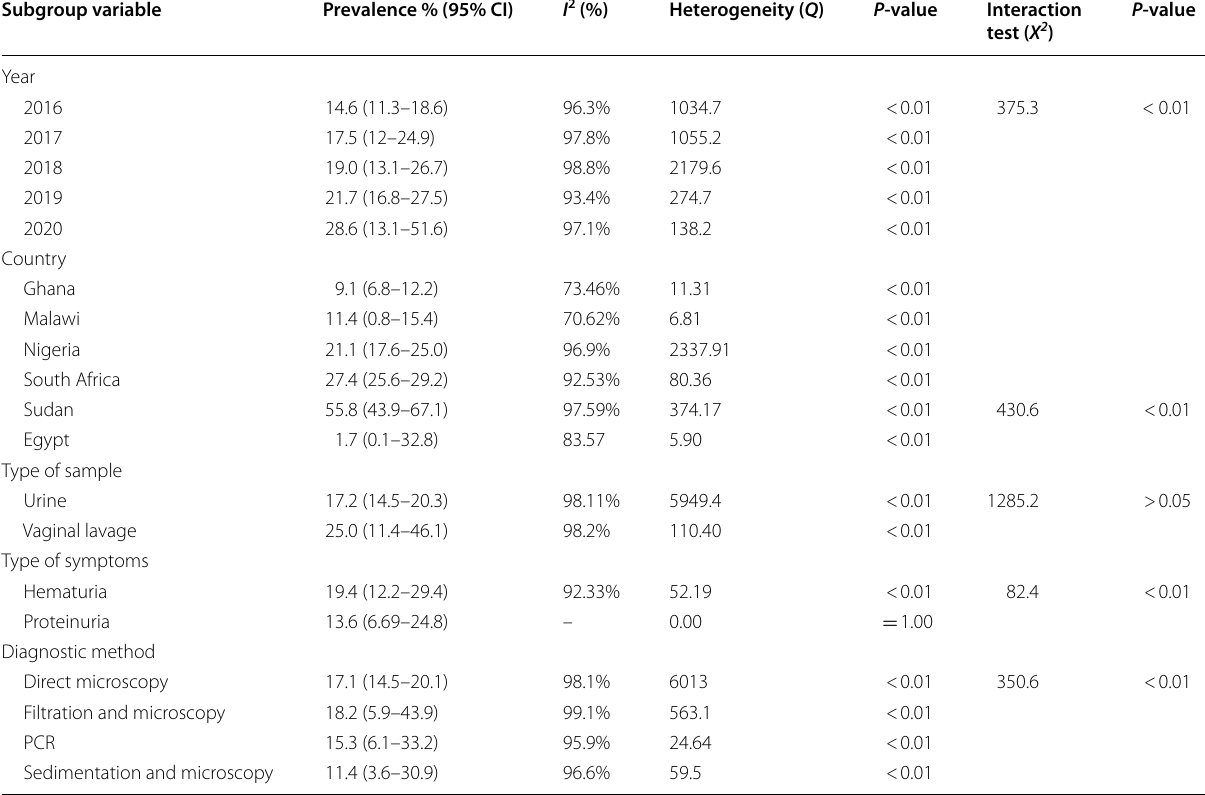
Table 2 Subgroup analysis of FUS prevalence according to year, country, type of sample, type of symptoms and diagnostic